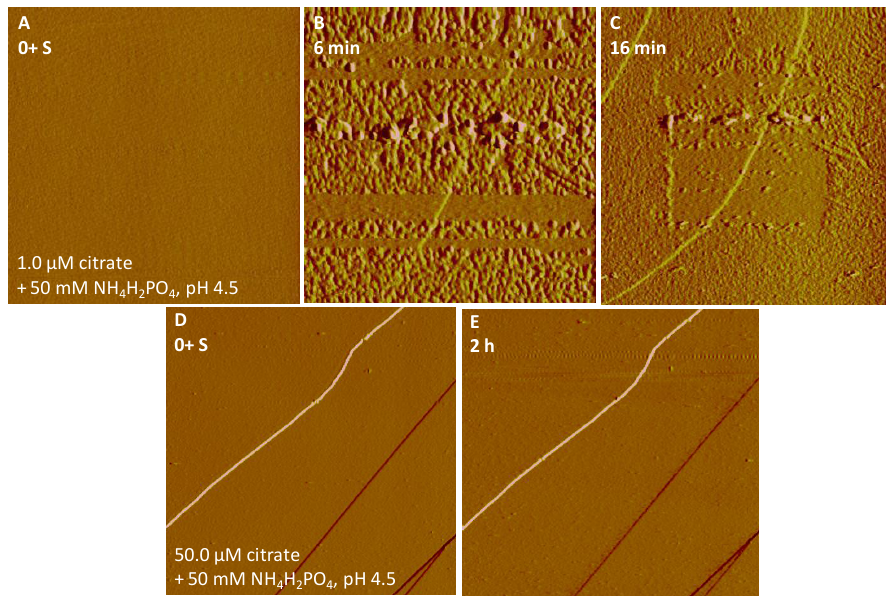
Figure 7. Nucleation kinetics of Fe-P phases on goethite in the presence of ( A – C ) 1.0 μM citrate and ( D , E ) 50 μM citrate with 50 mM NH 4 H 2 PO 4 at pH 4.5. AFM images, ( A , B ) 5 μm × 5 μm; ( C – E ) 10 μm × 10 μm.